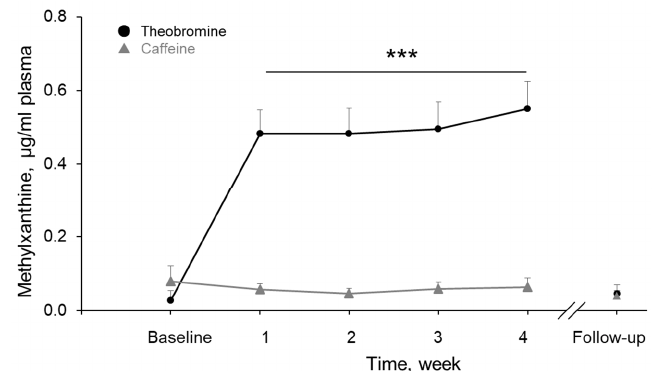
Figure 6. Changes in theobromine and caffeine concentrations in plasma of the DC group during the experimental period, including follow-up. Values are the means ± SEM. *** Significant differences vs. baseline at p < 0.001.